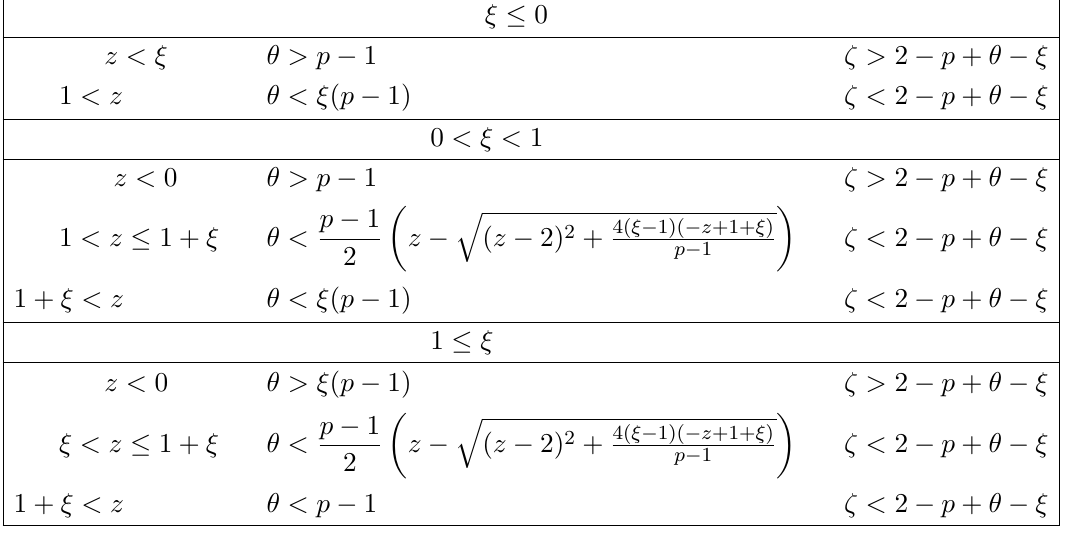
Table 2. Parameter range: Class II, V 0 >